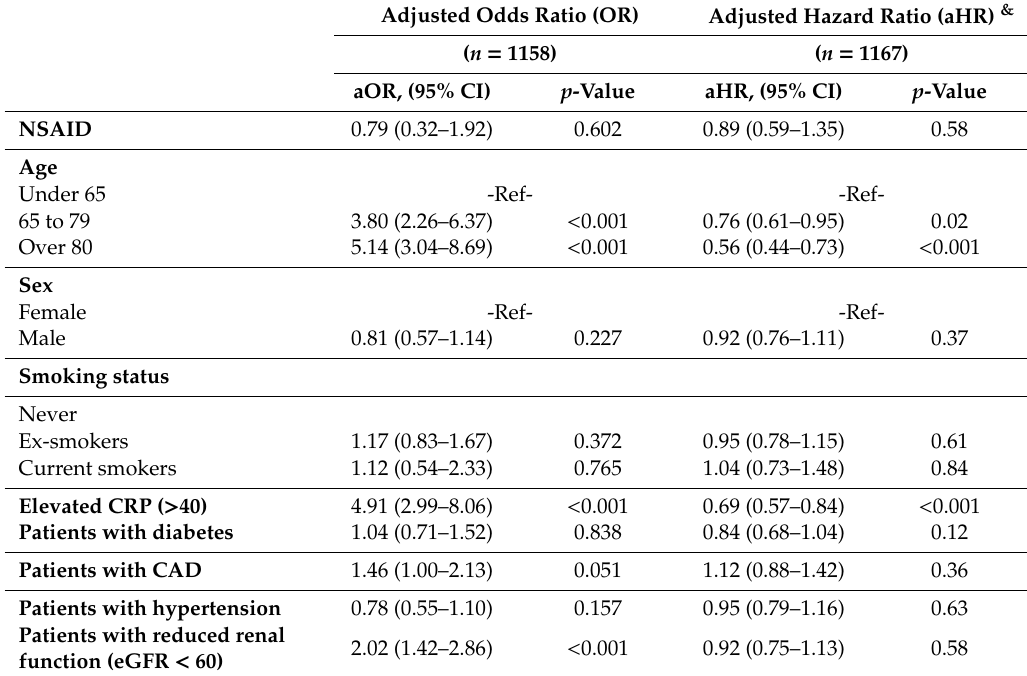
Table 3. Day-7 mortality and time to discharge. Multivariable